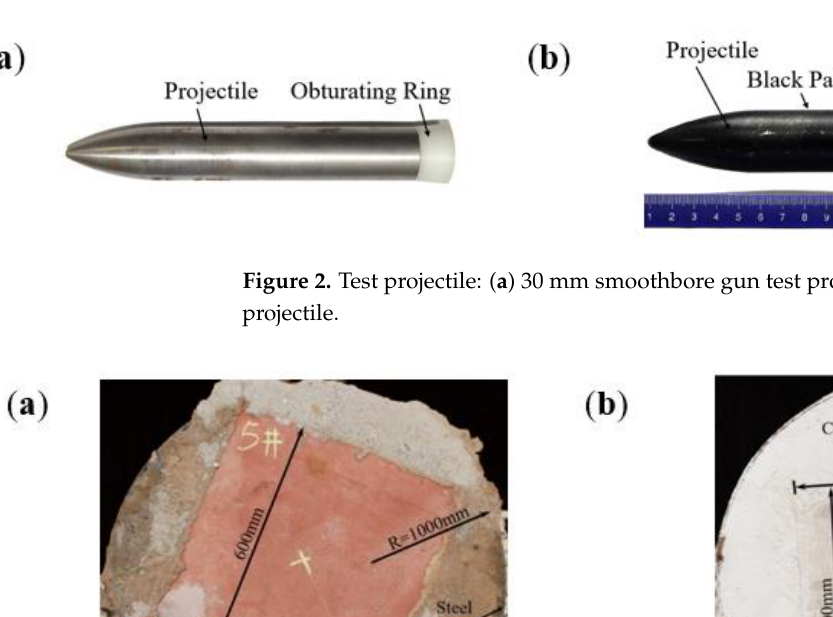
Figure 2. Test projectile: ( a ) 30 mm smoothbore gun test projectile; ( b ) 60 mm smoothbore gun test projectile.